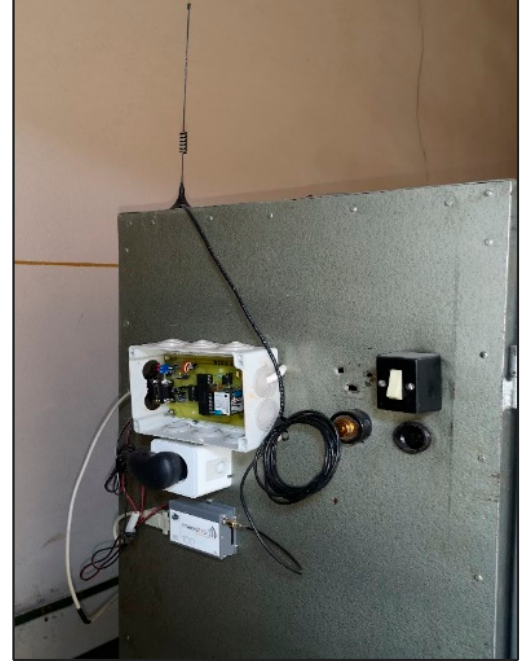
Figure 7. Switch heating remote control device, mounted on a metal panel.